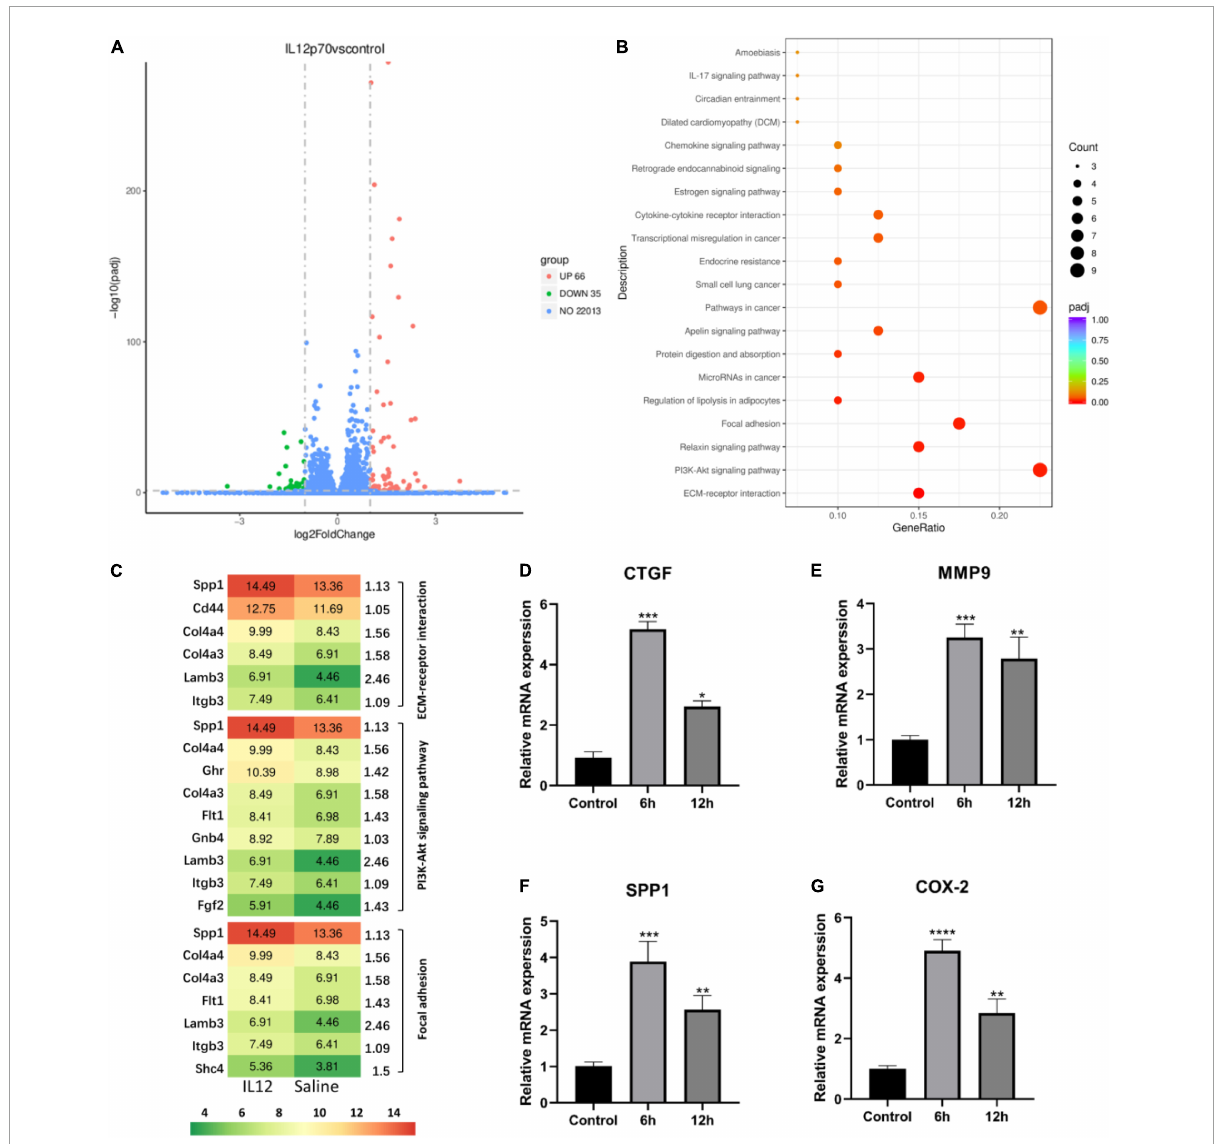
FIGURE4 Differentially expressed genes in IL-12 treated mouse podocytes. (A) A volcano plot of differentially expressed genes in the IL-12-treated group versus the control group of podocytes. A fold-change > 2 and adjusted P < 0.05 were used as the screening criteria. (B) The Kyoto Encyclopedia of Genes and Genomes (KEGG) pathway enrichment analysis results of differentially expressed genes in the IL-12 treatment group and control group. The color depth is related to the adjusted P -value. (C) The related genes associated with ECM–receptor interaction, PI3K-Akt, and focal adhesion signaling pathways. (D–G) Quantification of relative mRNA expressions of the CTGF , MMP9 , SPP1 , and COX-2 by qPCR. The podocytes in the IL-12-treated group were incubated with 400 ng/mL IL-12 for 6 h. ** P < 0.01, *** P < 0.001, **** P <